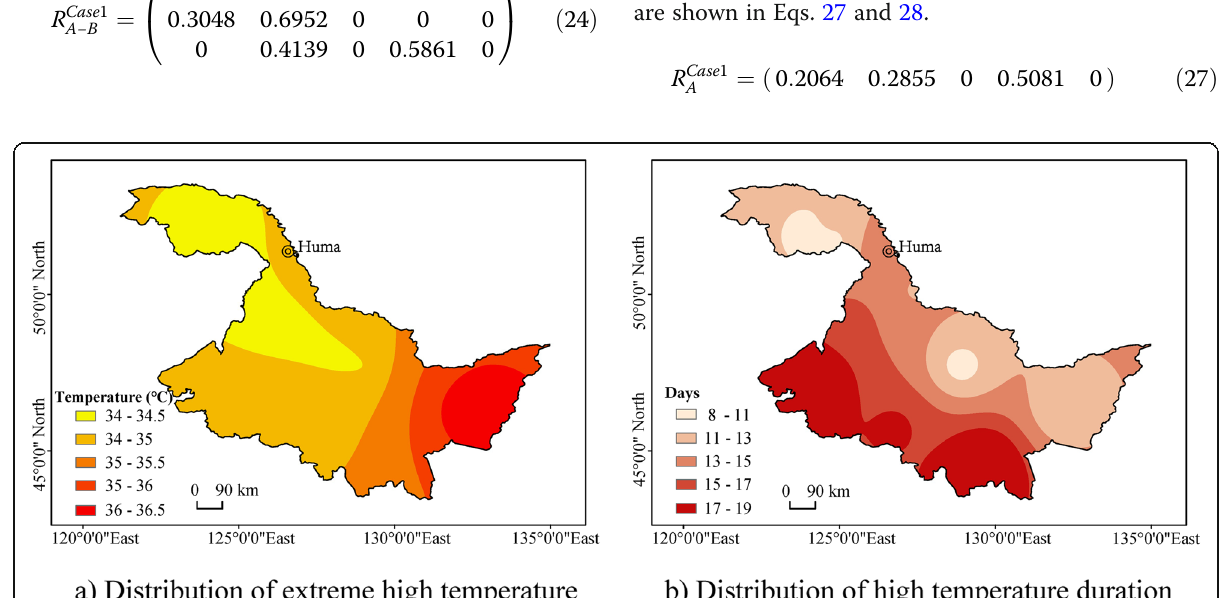
Fig. 6 Analysis scenario of once in twenty years (Case 1). a Distribution of extreme high temperature. b Distribution of high temperature